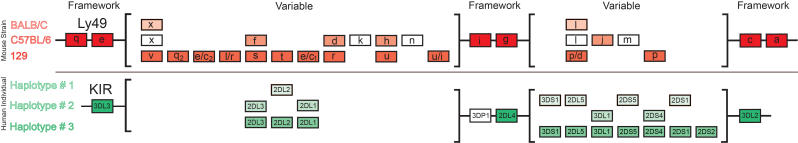
Differences in Organization of KIR Genes in Human Haplotypes and Ly49 Genes in Various Mouse StrainsThis figure is not drawn to scale, but it illustrates the presence of framework genes and the variable gene content in Ly49 genes in different mouse strains [72] and KIR sequences in human haplotypes. The vertical arrangement of genes within a family shows allelic relationships. White boxes indicate known pseudogenes. Please note that while many KIR haplotypes are possible, only a small selection has been shown here.